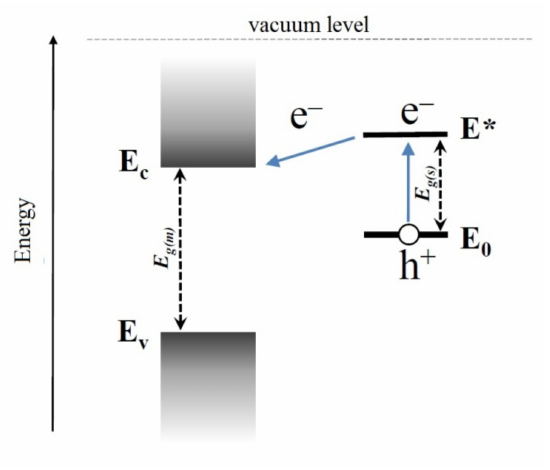
Figure 6. Schematic diagram of photosensitization